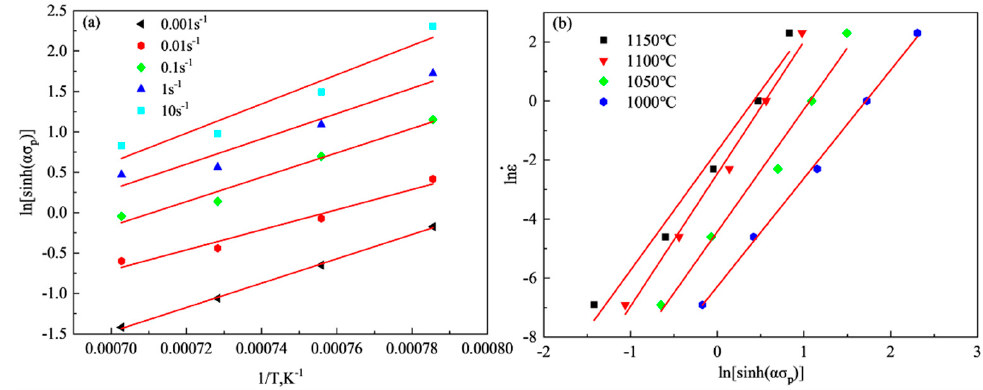
. Figure 4. ln[sin h ( 𝛼𝜎 (cid:3043) )] − 1/T and ln 𝜀(cid:4662) − ln[sin h ( 𝛼𝜎 (cid:3043) ) ] fitting curves for S280 steel: ( a ) ln[sinh( 𝛼𝜎 (cid:3043) )] − Figure 4. ln[sin h ( 𝛼𝜎 (cid:3043) )] − 1/T and ln 𝜀(cid:4662) − ln[sin h ( 𝛼𝜎 (cid:3043) ) ] fitting curves for S280 steel: ( a ) ln[sinh( 𝛼𝜎 (cid:3043) )] − Figure 4. ln[sin h ( ασ p )] − 1/T and ln ε − ln[sin h ( ασ p ) ] fitting curves for S280 steel: ( a ) ln[sinh( ασ p )] − 1/T; . 1/T; ( b ) ln 𝜀(cid:4662) − ln[sin h ( 𝛼𝜎 (cid:3043) ) ]. 1/T; ( b ) ln 𝜀(cid:4662) − ln[sin h ( 𝛼𝜎 (cid:3043) ) ]. ε − ln[sin h ( ασ p ) ( b ) ln